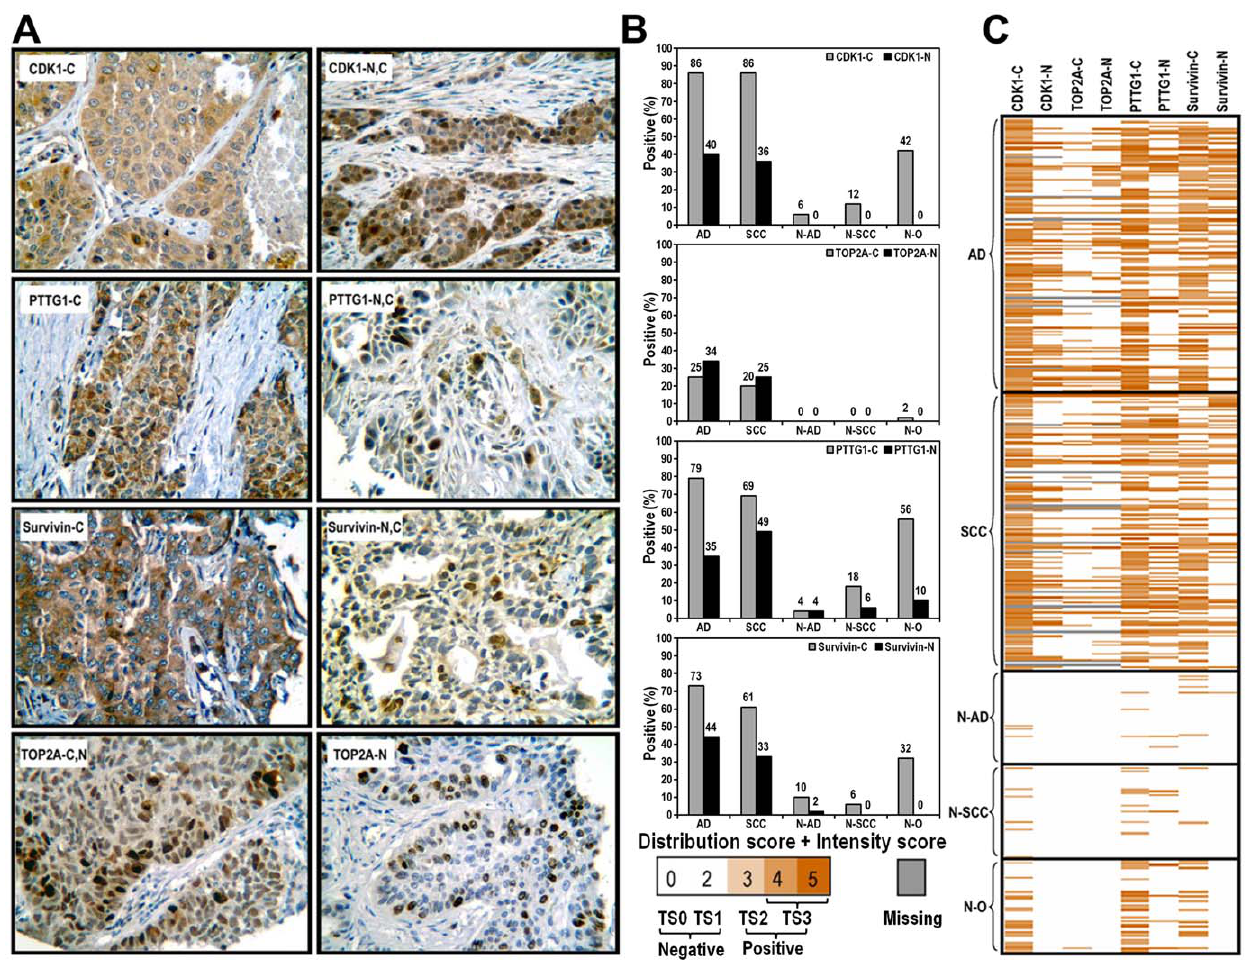
Figure 3. Tissue microarray immunohistochemistry. A. Examples of CDK1, PTTG1, Survivin and TOP2A subcellular staining in clinical tumor samples (-C: cytoplasmic staining; -N: nuclear staining). Staining is shown at 400 6 magnification. B. Tissue distribution of positive rates for CDK1, PTTG1, Survivin and TOP2A. AD: Adenocarcinoma; SCC: Squamous cell carcinoma; N-AD: Adjacent non-diseased lung tissues from Adenocarcinoma; N-SCC: Adjacent non-diseased lung tissues from squamous cell carcinoma; N-O: Non-pulmonary normal organs. C. Overview of entire tissue microarray staining for expression of these antigens in the cytoplasm or nucleus.